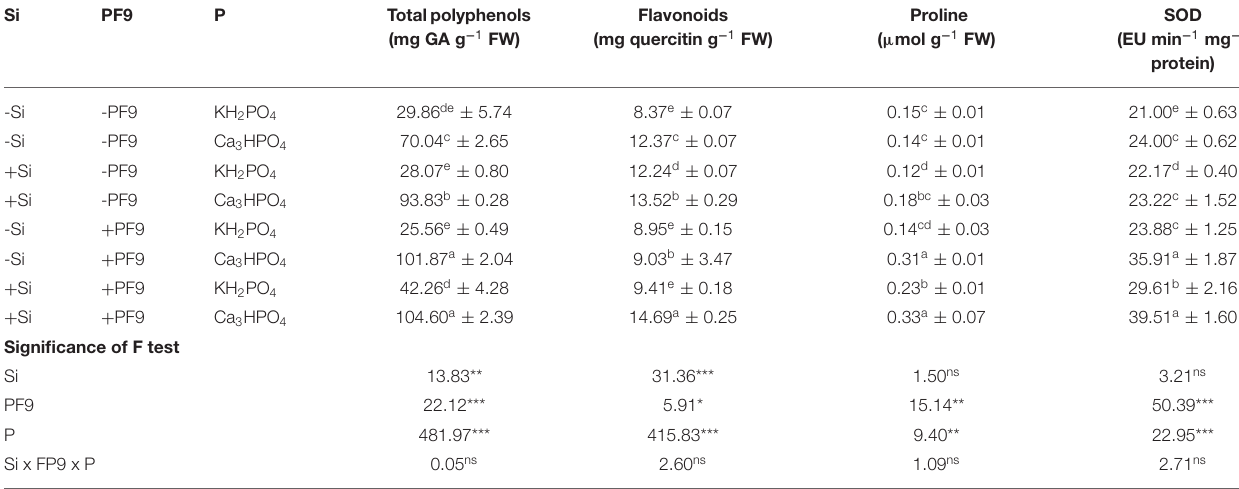
TABLE 3 | Effect of 3mM Si treatment, PF9 strain inoculation, and their combination on the enzymatic and non-enzymatic antioxidant activities of Medicago sativa (OL population) plants grown under 250 µ mol of the soluble (KH 2 PO 4 ) or insoluble (Ca 3 HPO 4 ) phosphorus